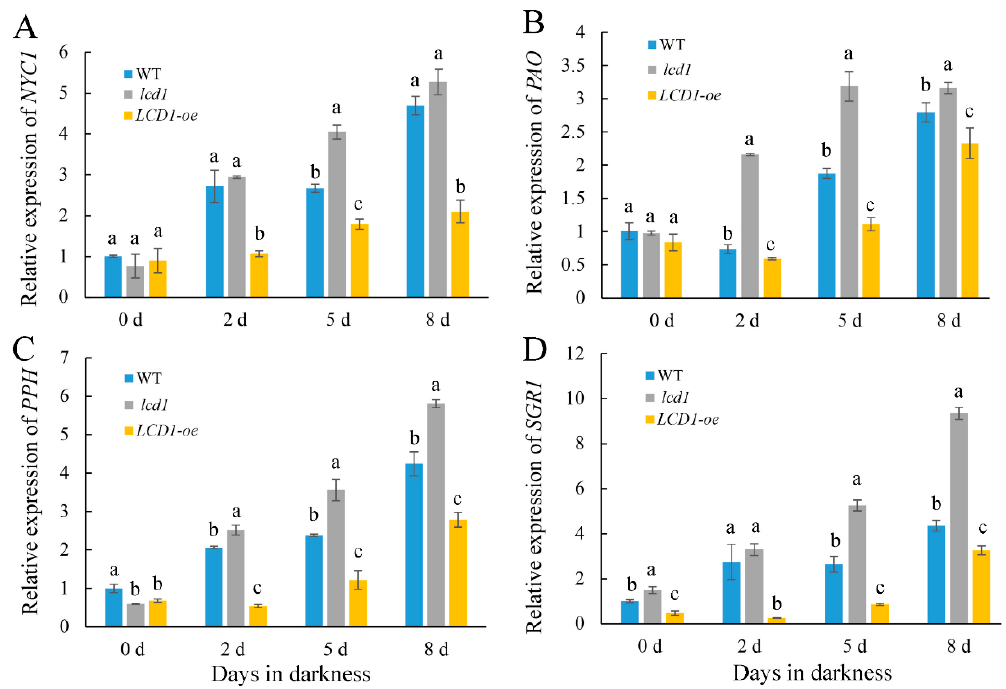
Figure 5. Changes in the gene expressions of chlorophyll degradation related genes: ( A ) NYC1 , ( B ) PAO , ( C ) PPH , and ( D ) SGR1 in detached leaves of 6-week-old wild-type (WT), lcd1 , and LCD1-oe tomatoes stored in darkness for 0, 2, 5, and 8 days. Data are means of three biological replicates ± standard deviation (SD). Different letters above the columns stand for significant difference between two values ( p < 0.05) at the same time point.